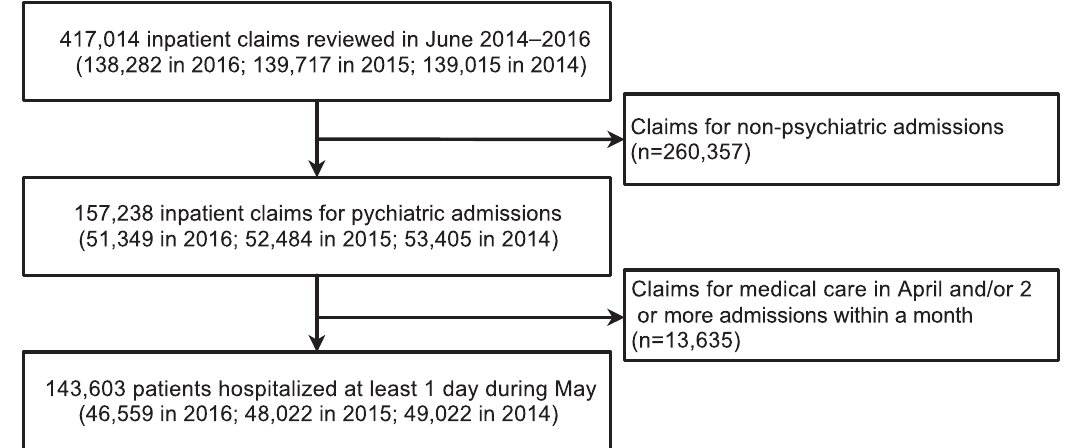
Figure 1. Flow diagram of the study